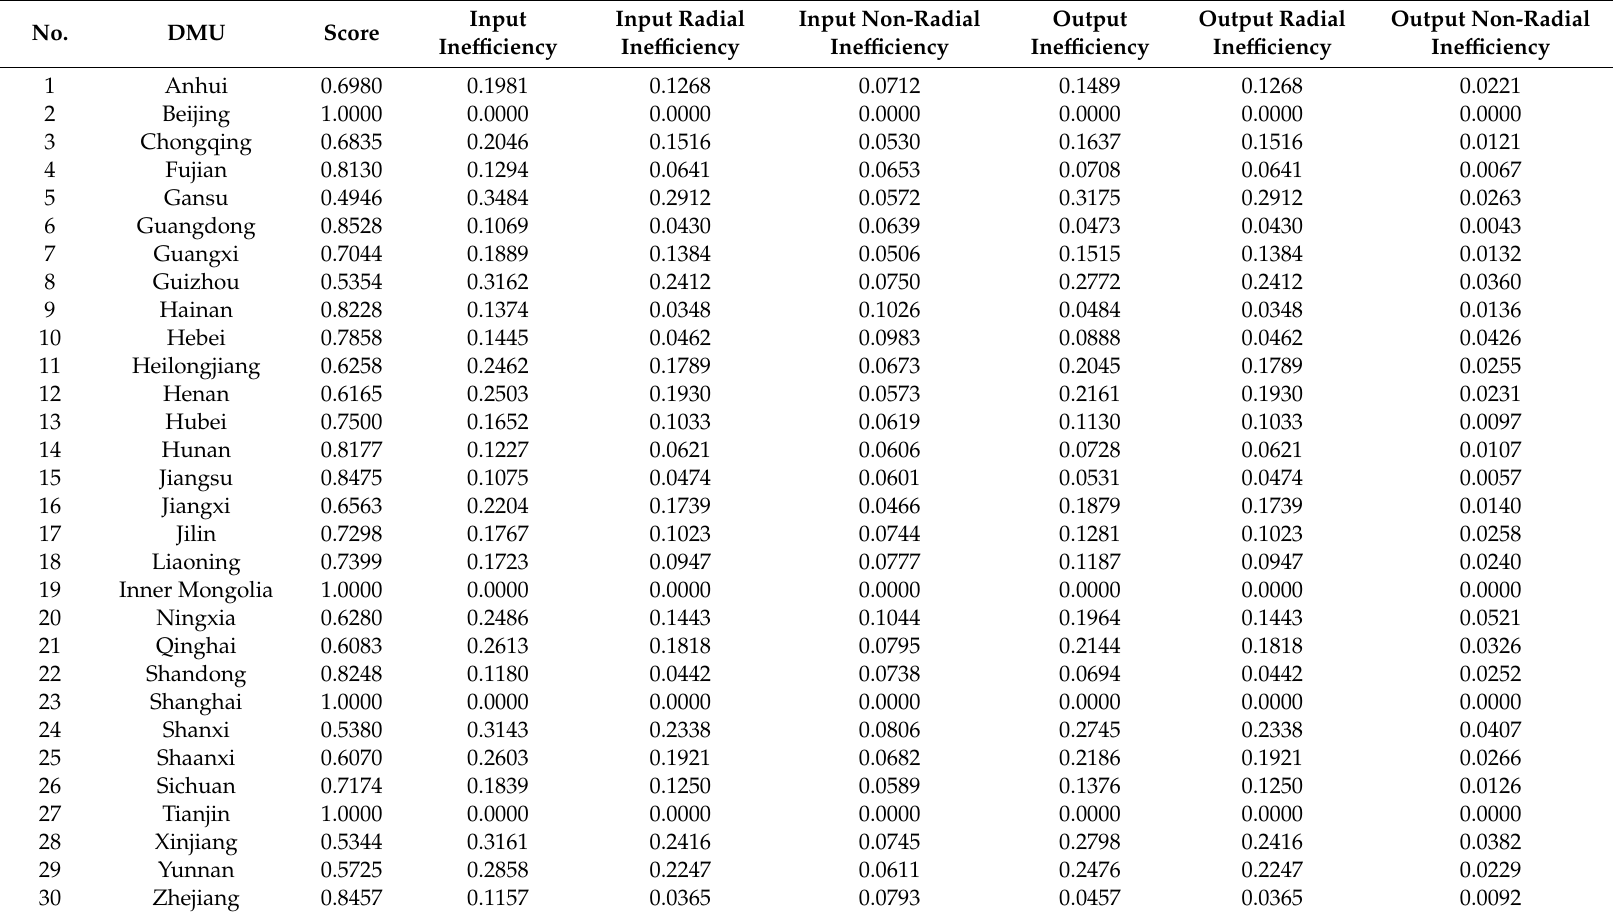
Table 4. 2013 input and output indicator radial and non-radial ine ffi ciency